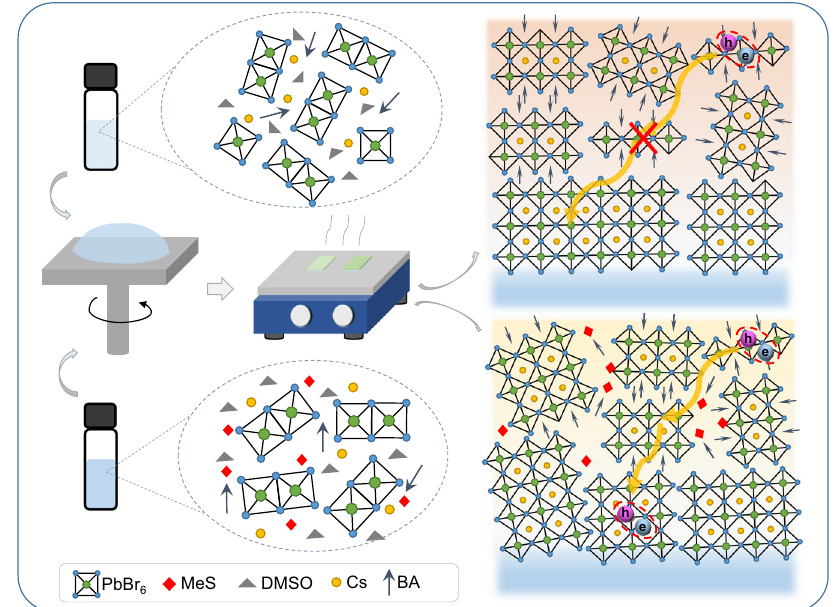
Fig. 1 Effects of MeS on phase distribution of BA 2 Cs n − 1 Pb n Br 3 n + 1 perovskite fi lms. Schematic illustrations of the colloidal clusters ’ structures in precursor solutions and phase distributions of n values in fi lms after thermal annealing without (top pathway) and with (bottom pathway) addition of MeS, where different energy transfer pathways from small- n phases to large- n phases are presented. Crystal orientations in the perovskite fi lms were veri fi ed by grazing-incidence wide-angle X-ray scattering (GIWAXS) measurements (see Supplementary Fig.